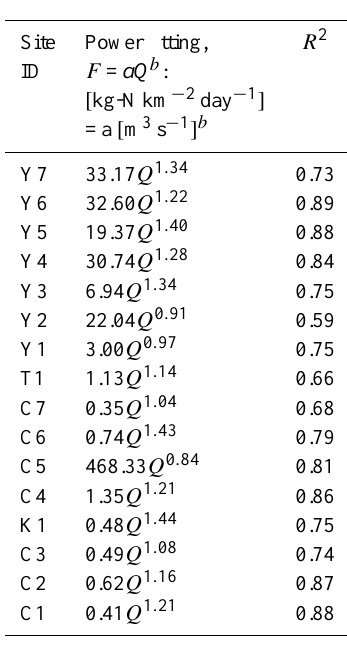
Table 4. The rating curves of NO 3 -N fluxes against water dis- charge.